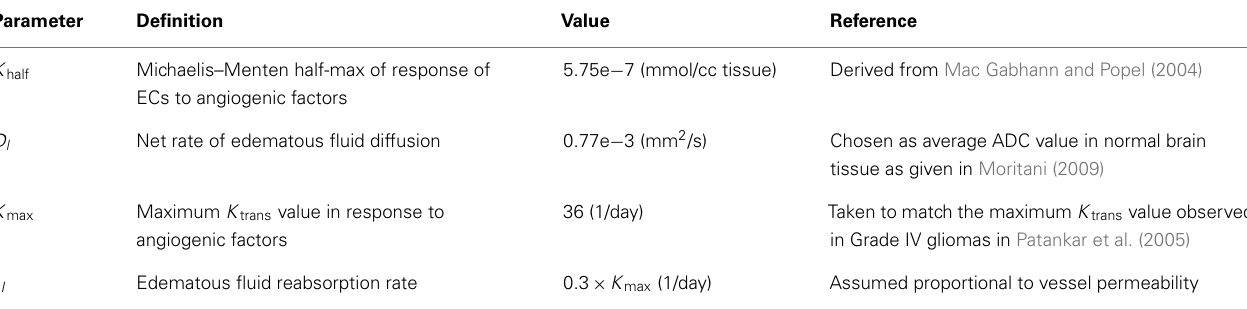
Table 2 | Parameter values for the edema equation used in all simulations unless stated otherwise in the text.